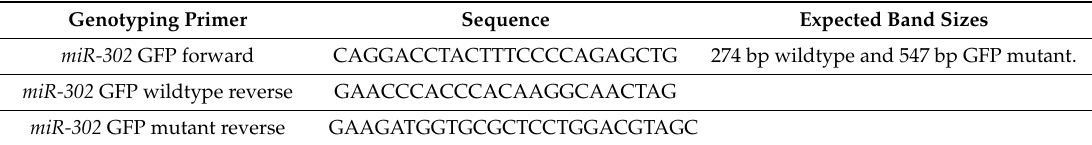
Table 1. PCR primers and expected band